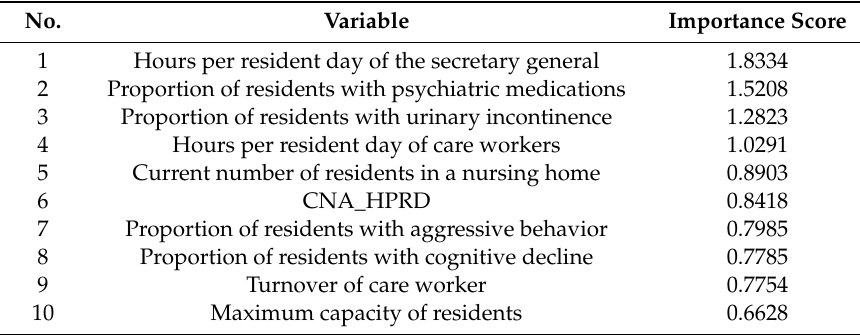
Table 2. Description of